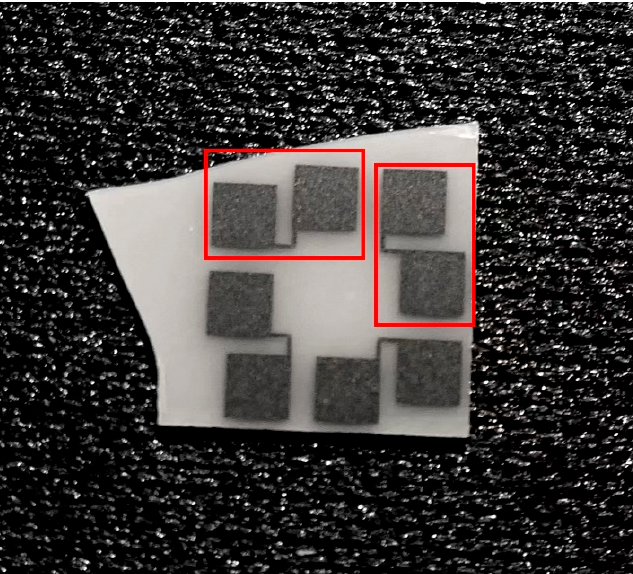
Figure 6. Sample electrical connection diagram (the red line frames out two Pt film sensing units adjacent to each other).